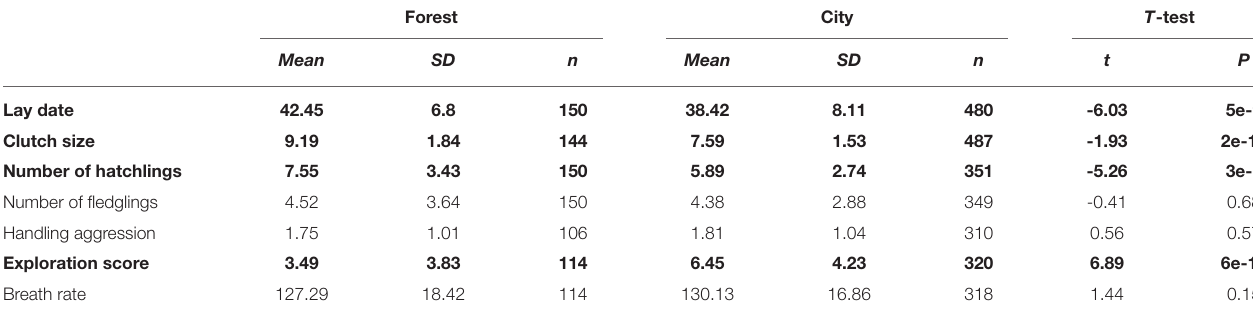
TABLE 2 | Comparison of mean traits between forest and city great tits based on the full monitoring dataset (hence including broods with unknown parents). Forest